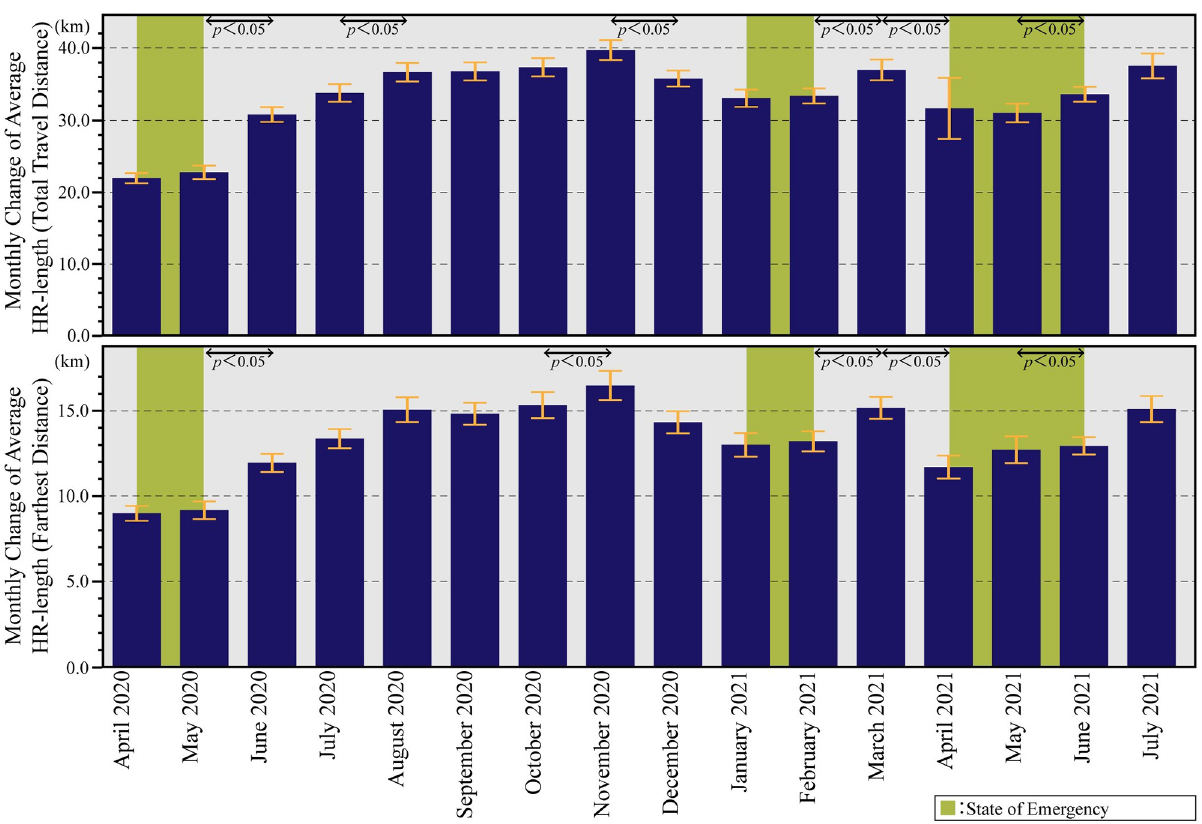
Fig 4. Monthly Change of HR-length. The upper graph shows the monthly changes in HR-length (Farthest Distance). The lower graph shows the HR- length (Total Travel Distance). The figures shows the average and 95% intervals of the HR-length in a time series. Besides, the Wilcoxon rank-sum test indicates significant differences in the average values for each month. Green periods are during the state of emergency, and yellow-green periods are during the priority prevention measures.